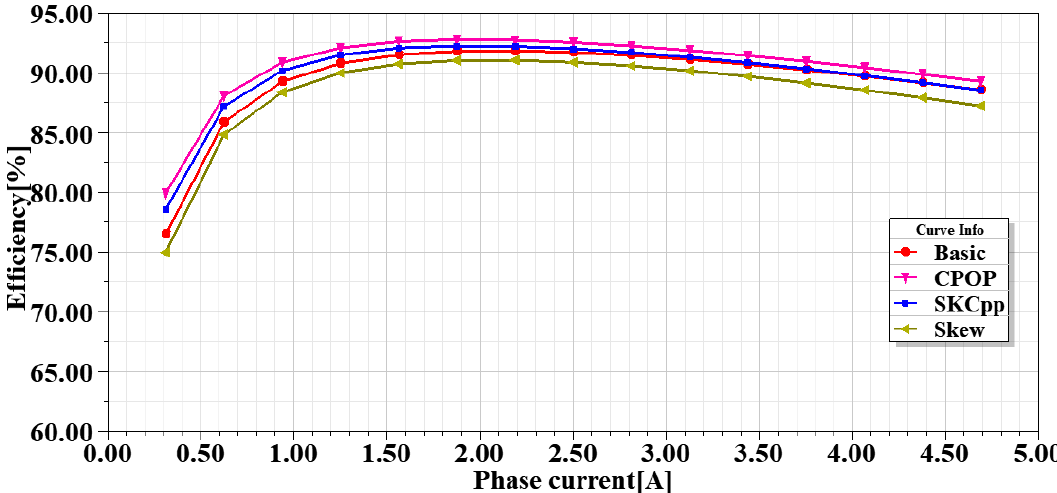
Figure 32. Efficiency against phase current (rms) for each rotor designs @ 375 r/min.